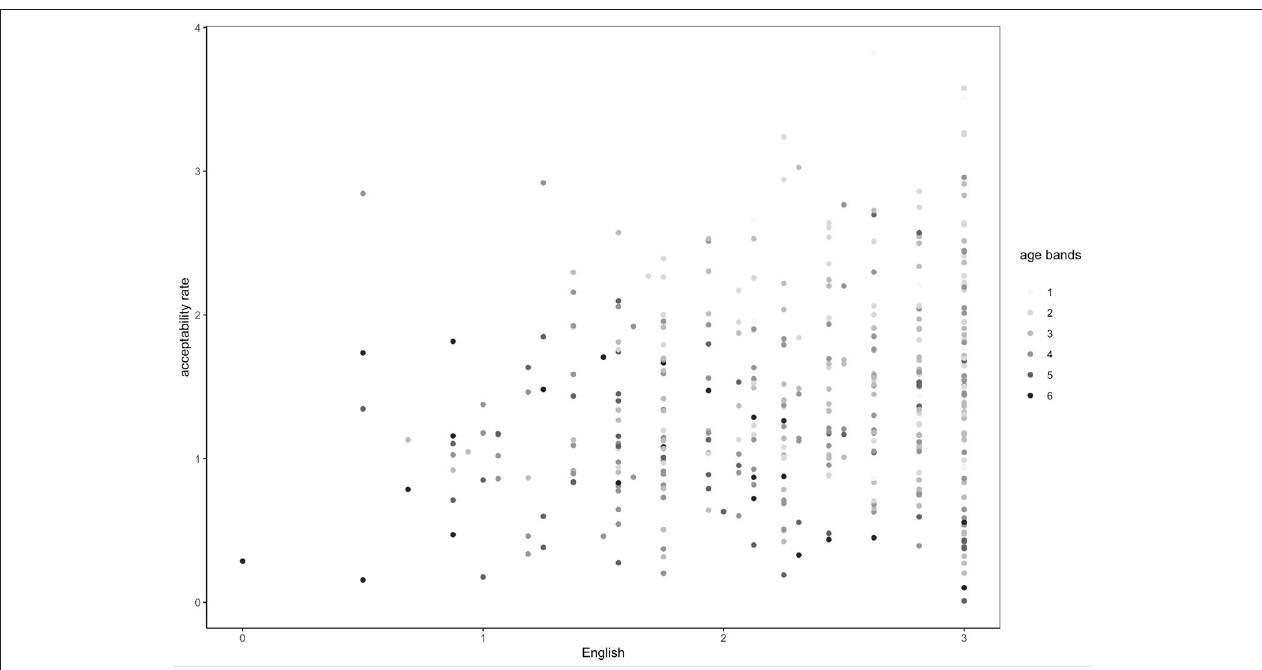
FIGURE 2 | Acceptability rate of all adjectives by exposure to and proficiency in English by age bands (1 = under 20, 2 = 21–30, 3 = 31–40, 4 = 41–50, 5 = 51–60, 6 =